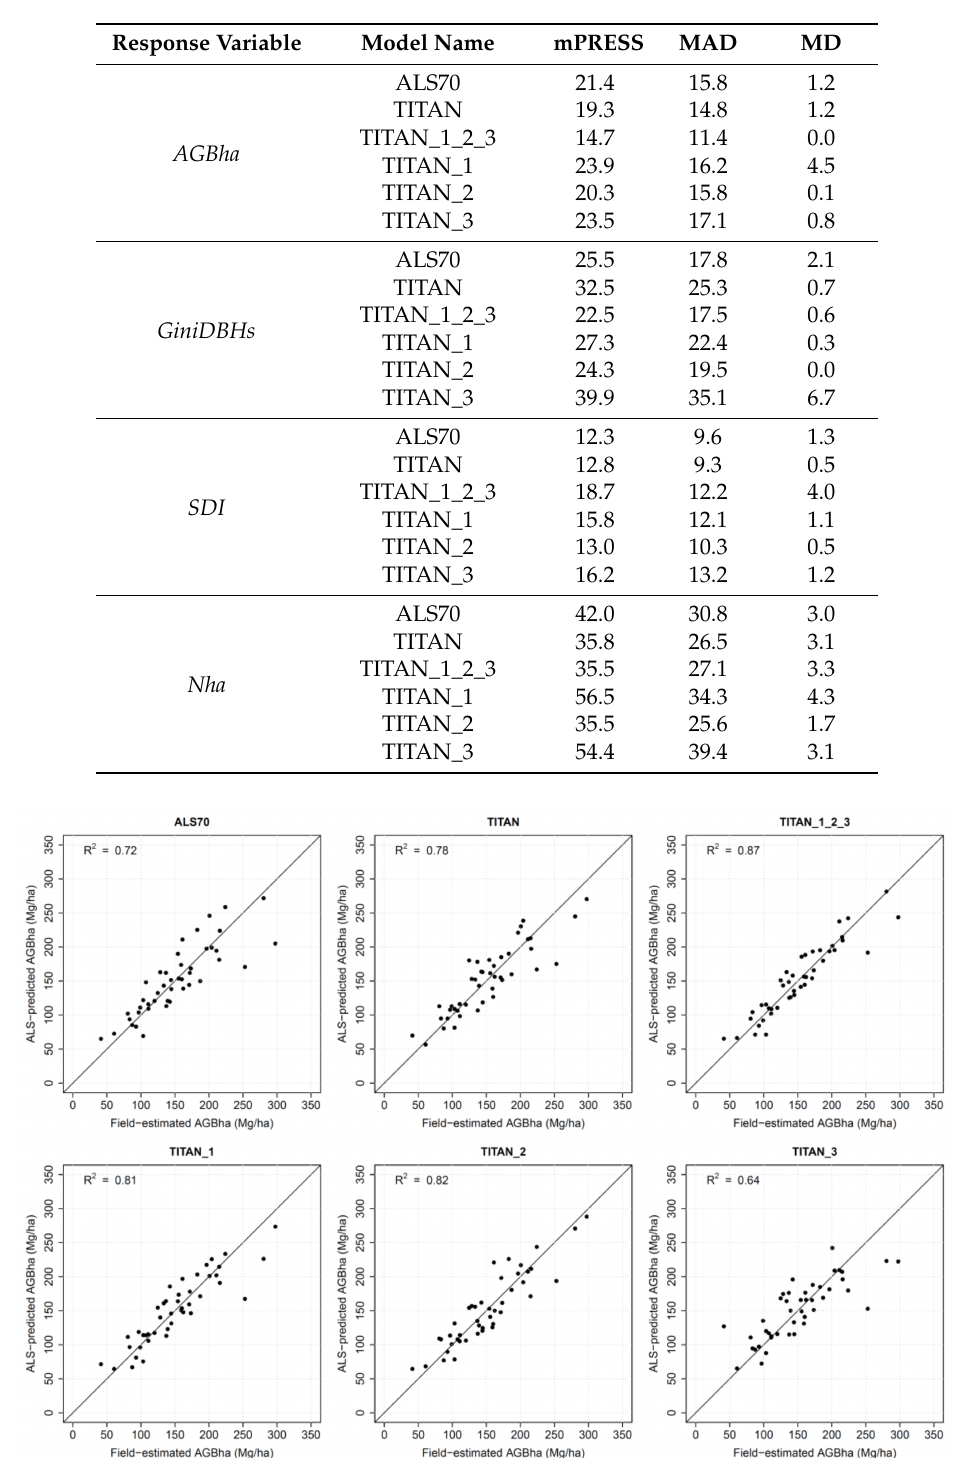
Table 5. Models’ goodness-of-fit: (i) mean residual error sum of squares (mPRESS) defined as the PRESS statistic divided by the sample size (the same for all models); (ii) the mean absolute deviation (MAD); and (iii) the mean deviation (MD).